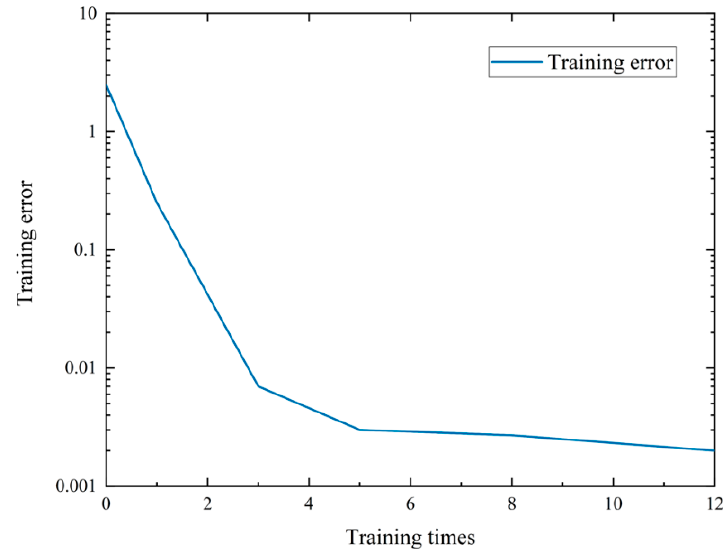
Figure 4. Training error curve of network.